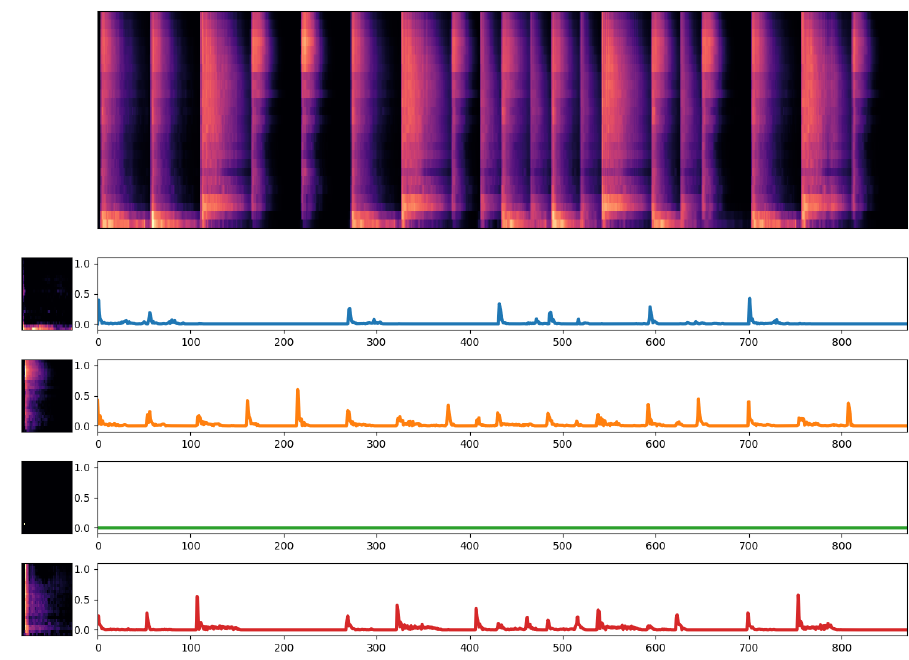
Figure 4. Decomposition of a drum loop using sparse NMFD, λ = 0.1. Although slightly more peaked than the activations for unconstrained NMFD (Figure 2), the activations do not show impulse- like behavior, and still contain noisy regions where it is difficult to detect individual drum hit onsets. The third component has become “inactive” in order to minimize the sparsity constraint.